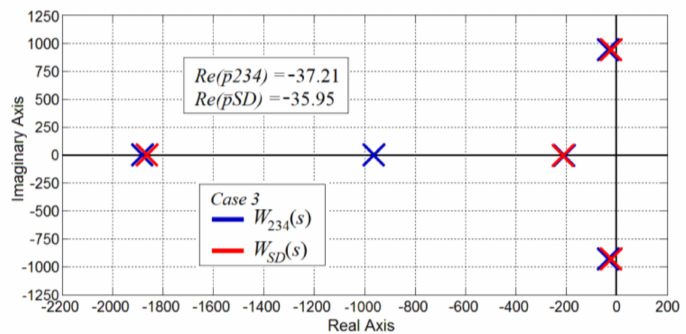
Figure 7. System poles, transfer function W ( s ) (Case